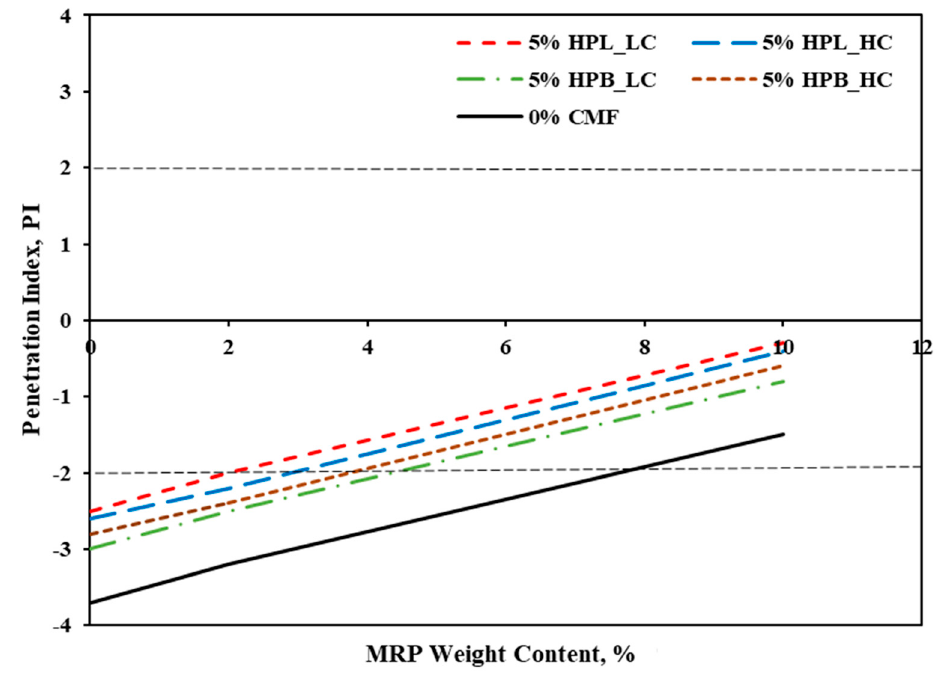
Figure 9. Effect of MRP content and CMF type on penetration index at 5% CMF content.